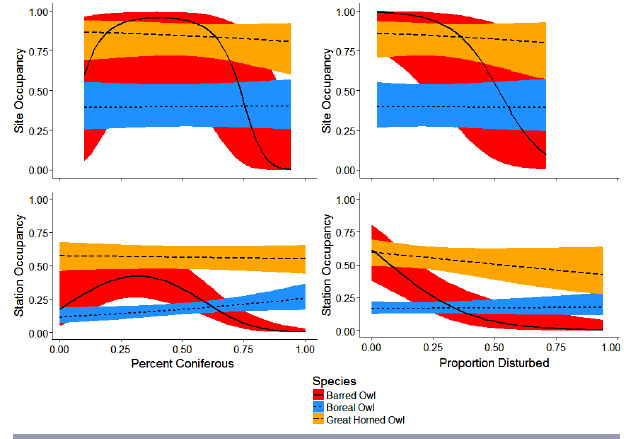
Fig. 3 . Site level model predictions of occupancy (left panels) and detection probability (right panels) for Barred Owls ( Strix varia ; A, B), Great Horned Owls ( Bubo virginianus ; C, D), and Boreal Owls ( Aegolius funereus ; E, F) for the three noise categories of sites. Predictions are averaged from models within 4 Δ AIC of the top model (Table 2). For Great Horned Owls, c none of the models within 4 Δ AIC contained noise category as c a factor for either the occupancy or the detection parameters. Fig. 4 . Model averaged predictions (models within 4 Δ AIC So we made predictions based on the highest ranked models the top model; Table 2, Table 3) for all three owl species for containing noise category as a factor for either the occupancy occupancy at two spatial scales: at the site level (top panels), or the detection parameters (Table 2). The error bars are 95% and at the station level (bottom panels) as a function of forest confidence intervals. Owl photos taken by J. Shonfield. composition (% coniferous forest) and landscape disturbance (proportion of the area disturbed by humans resulting in loss of forest cover). The solid or dashed lines are the model averaged predictions and the colored bands are the 95% confidence